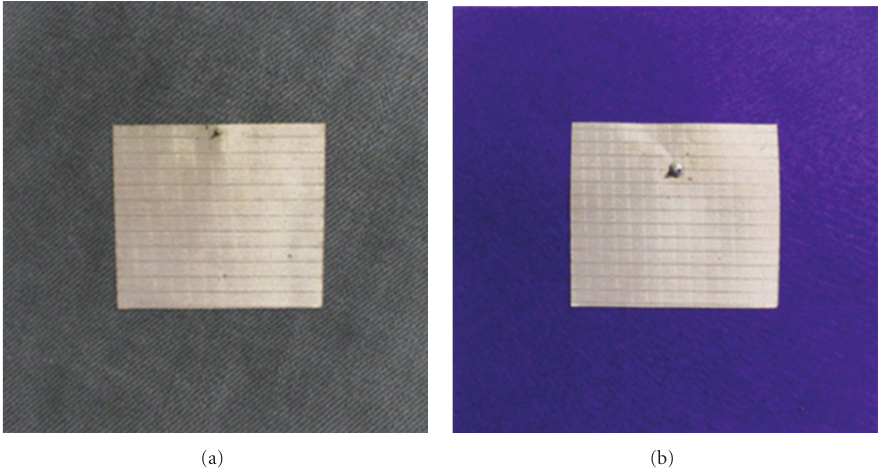
Figure 7: Patch antenna on denim (a) and felt (b) using Shieldit Super electrotextile.